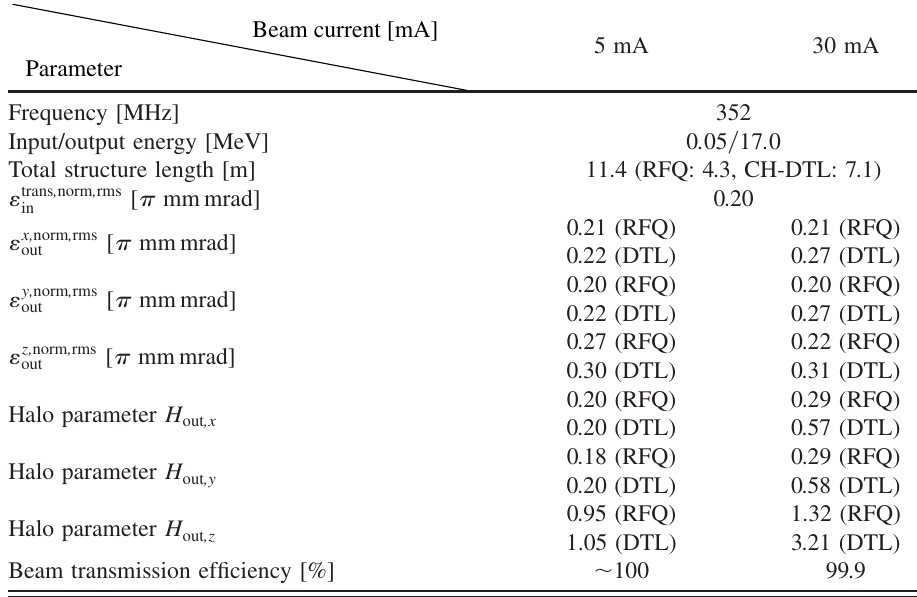
TABLE II. Main design and simulation results of the injector.